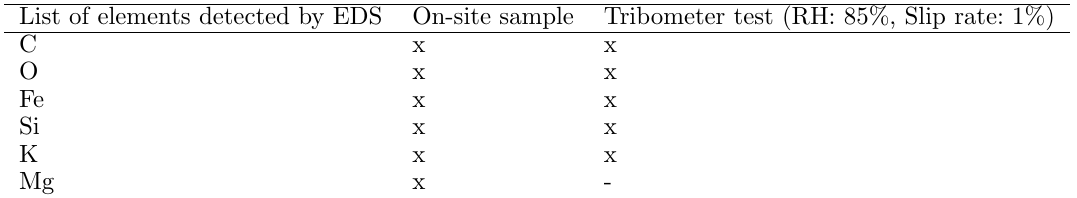
Table 3. Comparison of elements after EDS analysis performed on several samples (on site and laboratory). List of elements detected by EDS On-site